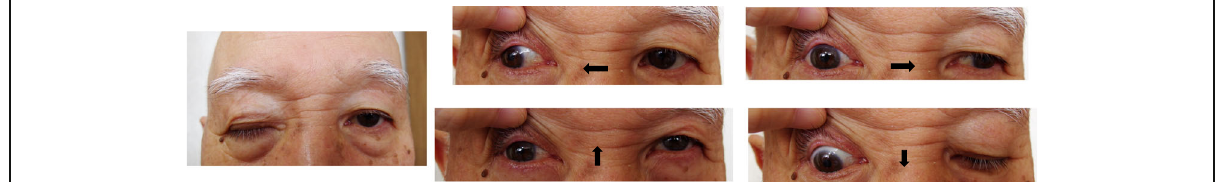
Fig. 1 Neuro-ophthalmologic examination before treatment initiation shows right palpebral ptosis and paresis of the third right canal